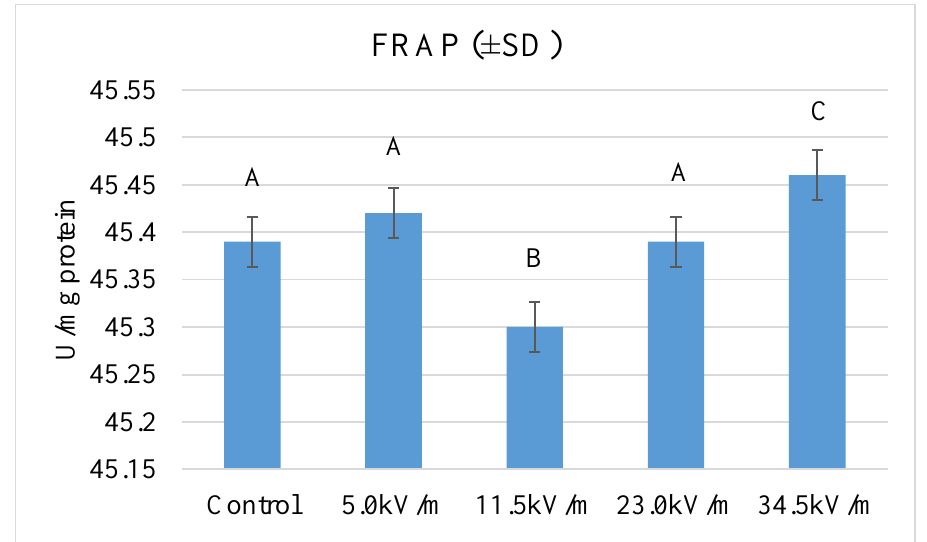
Figure 3. Ferric reducing antioxidant power (FRAP) in honeybee hemolymph after exposure to the E- field (50 Hz and different intensities). Details as in Figure 1. Statistical differences between the mean values for groups are marked with different letters. Different letters mean the difference is at the p - value ≤ 0.05 significance level.